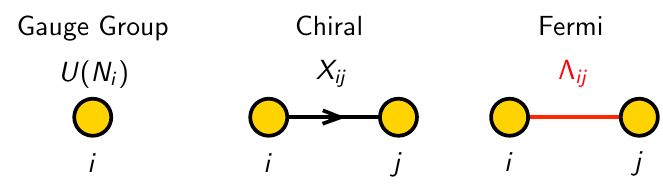
Table 1 . The Type IIA brane configuration for brane brick models.